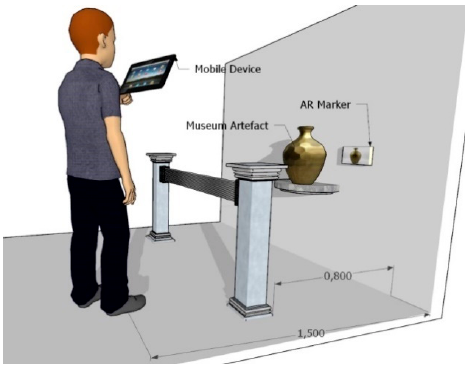
Figure 2. Physical setting of the augmented object projection (observer’s view).